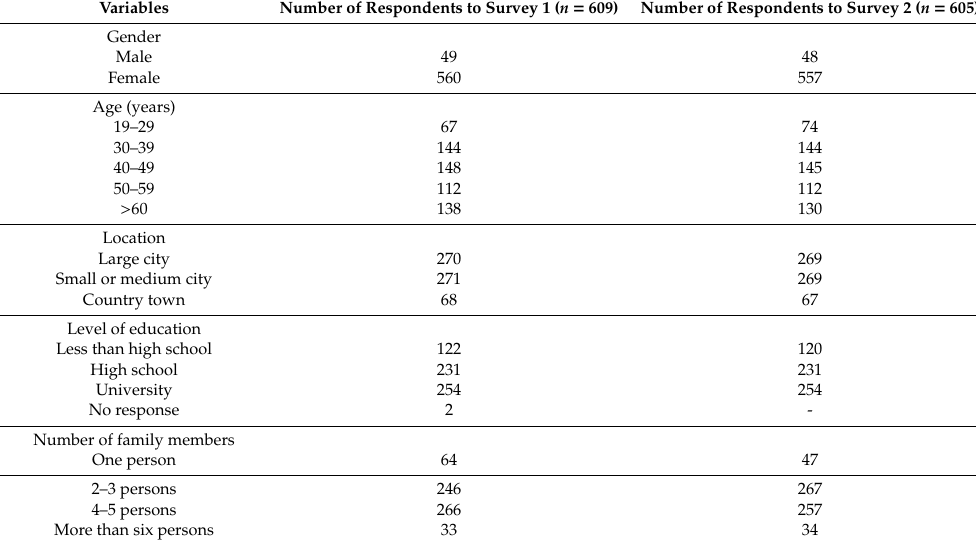
Table 1. Sociodemographic characteristics of the